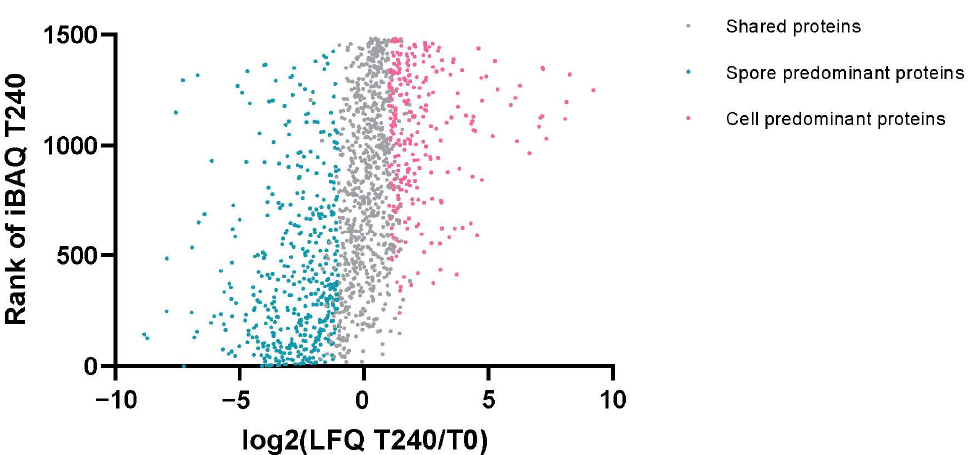
Figure 3. Scatter plot of the proteome comparison of the spore and vegetative cells. The y -axis was the protein rank according to the iBAQ intensity at T240 (vegetative cells). Proteins with higher iBAQ intensities at T240 ranked lower. The x -axis is the log2 transformed LFQ intensity ratio of T240 and T0. The predominant proteins were determined using the limma algorithm.